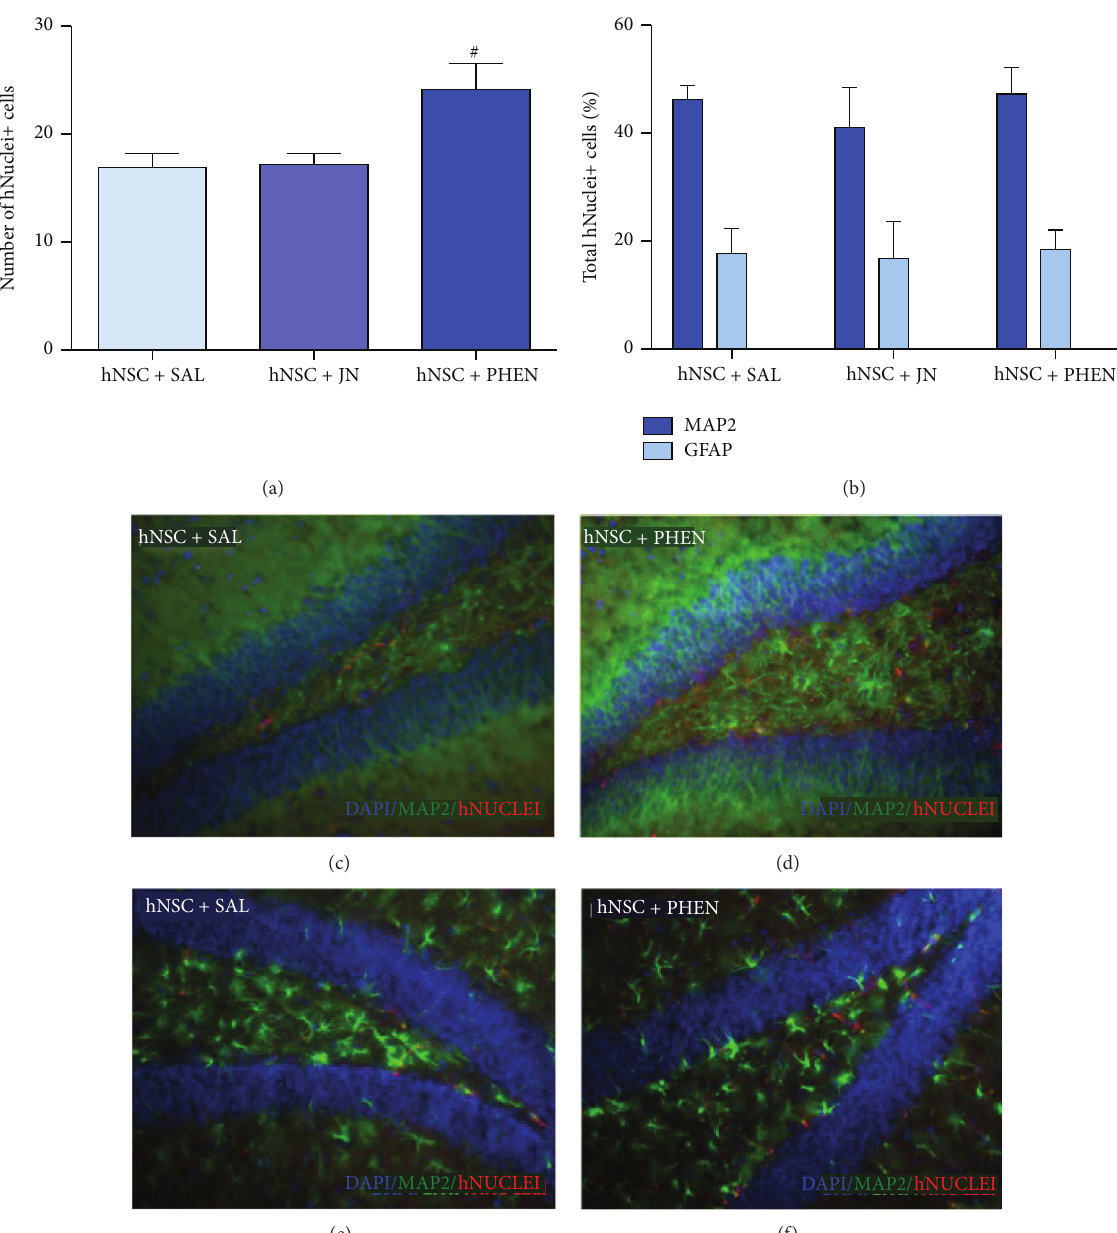
Figure 3: Treatment with (+)-phenserine increases the survival of transplanted hNSCs in the dentate gyrus of Tg2576 mice. (a) The total number of cells labeled with anti-human nuclei (hNuclei) and with 4 󸀠 ,6-diamidino-2-phenylindole (DAPI) nuclear counterstain following transplantation of hNSCs into the dentate gyrus (DG) in Tg2576 mice. (b) The proportion of cells showing immunoreactivity for microtubule- associatedprotein2(MAP2)orglialfibrillaryacidicprotein(GFAP),normalizedtothetotalnumberofhNuclei+cells(%)intheDGofTg2576 mice. (c-d) Representative images of cells stained with hNuclei (red) and with MAP2 (green) in the DG of hNSC-transplanted mice treated with (c) saline (hNSC + SAL) or (d) (+)-phenserine (hNSC + PHEN) at 20x magnification. (e-f) Representative images of cells stained with hNuclei (red) and with GFAP (green) in the DG of hNSC-transplanted mice treated with (e) saline or (f) (+)-phenserine at 20x magnification. Cell nuclei were visualized with DAPI. # 𝑝 < 0.05 compared to hNSC + SAL. The data are expressed as means ±